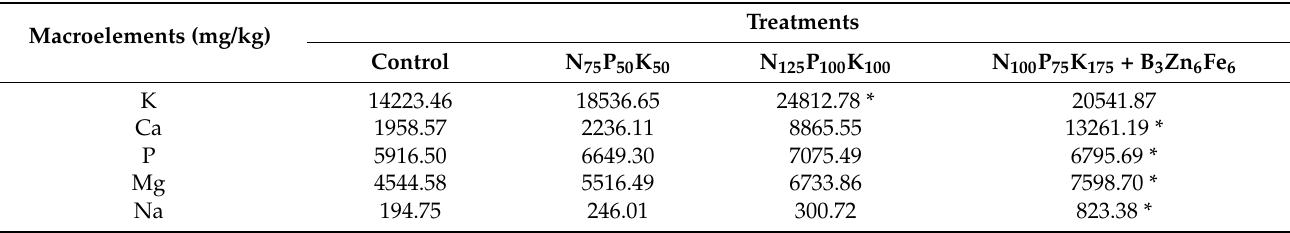
Table 1. The impact of mineral fertilisers on macroelement content of turmeric rhizome grown in soil–climate conditions of Tashkent Region.